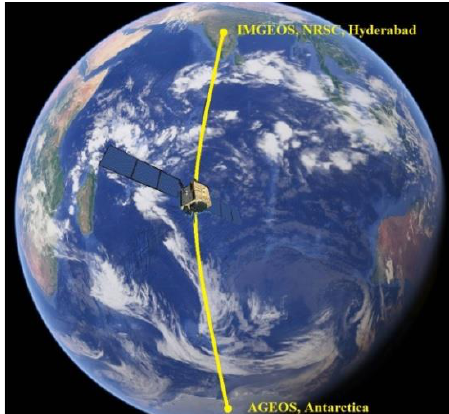
Figure 1. IMGEOS and AGEOS locations (North pole tilted back to show Antarctica for